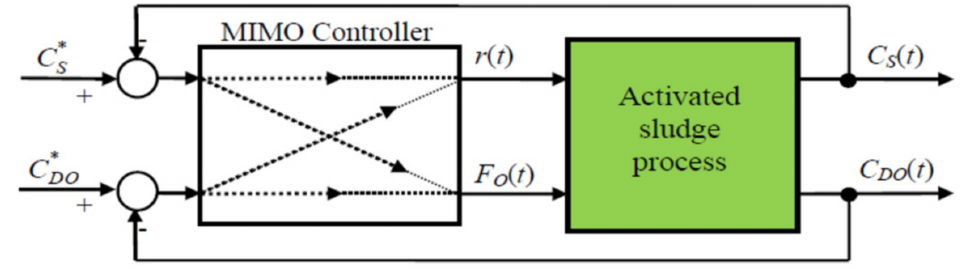
Figure 4. The decoupling multivariable adaptive control structure of the ASP